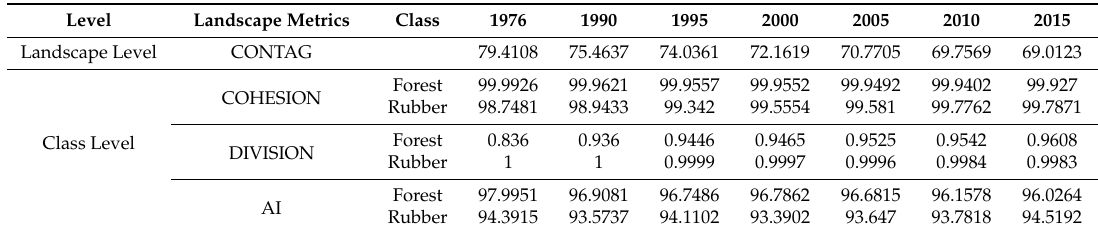
Table 5. Variation of landscape configuration and